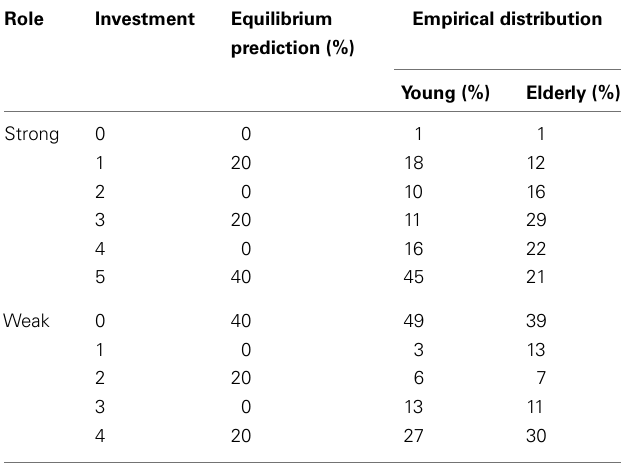
Table 2 | Comparison of Nash equilibrium prediction with the empirical frequencies from young and elderly cohorts.